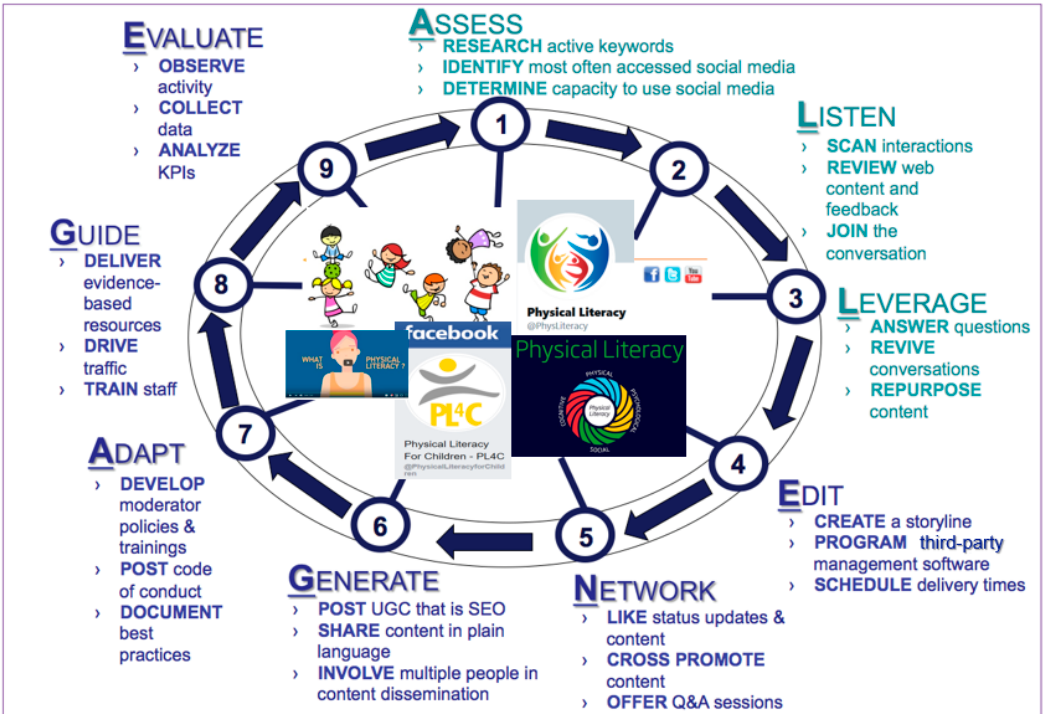
Figure 1. ALL-ENGAGE Playbook for advancing youth physical literacy on social media.